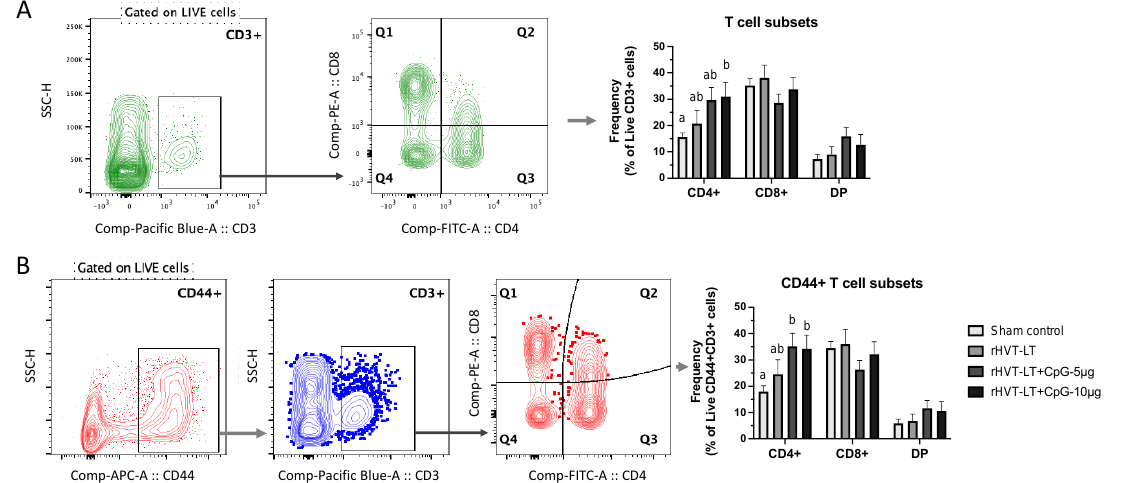
Figure 5. Effect of CpG-ODN on T-cell responses in one-day-old chicks. Single-cell splenocyte suspensions were prepared to obtain mononuclear cells and stained with anti-chicken monoclonal antibodies against CD3, CD4, CD8, and CD44 markers. The basic gating strategy included excluding doublets from the populations and gating on live cells. ( A ) Representative plot showing CD3+ gated population and a quadrant plot gated on CD3+ cells showing T cell subsets, CD4+ (Q3), CD8+ (Q1), and double-positive (DP) (Q2) cells along with the bar chart depicting their cellular frequencies. ( B ) Representative plots showing cells expressing CD44 gated on live cells to obtain CD3+ cells followed by quadrant gating showing T-cell subsets, CD44+CD4+ (Q3), CD44+CD8+ (Q1), and CD44+ DP (Q2) cells along with the bar chart depicting their cellular frequencies. Different letters above the standard-error-of-mean bars within each of the data set graphs indicate significant statistical difference ( p < 0.05) between the